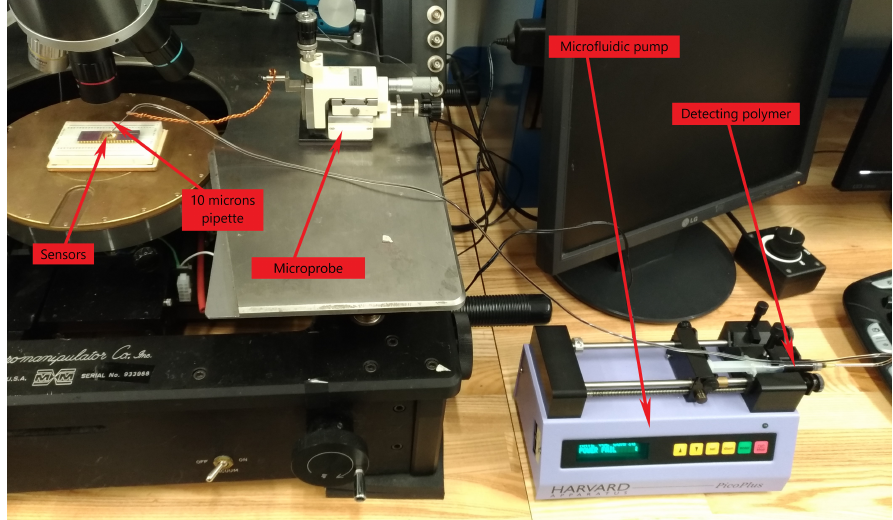
Figure 9. The experimental setup for sensor